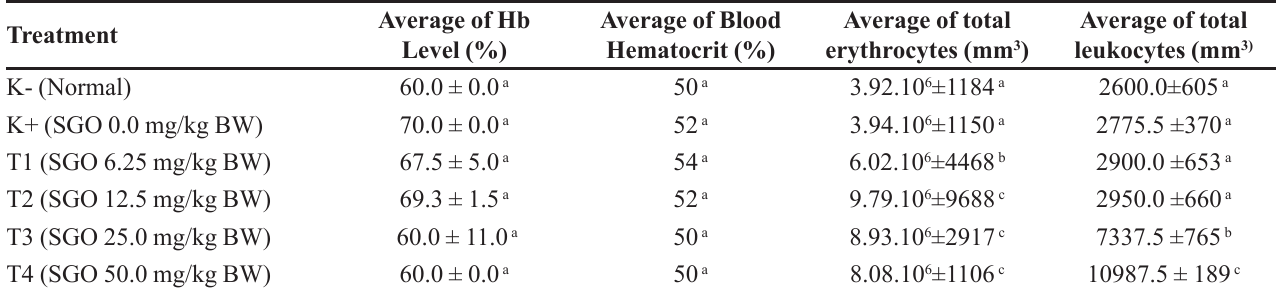
TABLE II - The average of hemoglobin level, blood hematocrit, total erythrocyte and total leucocyte in mice